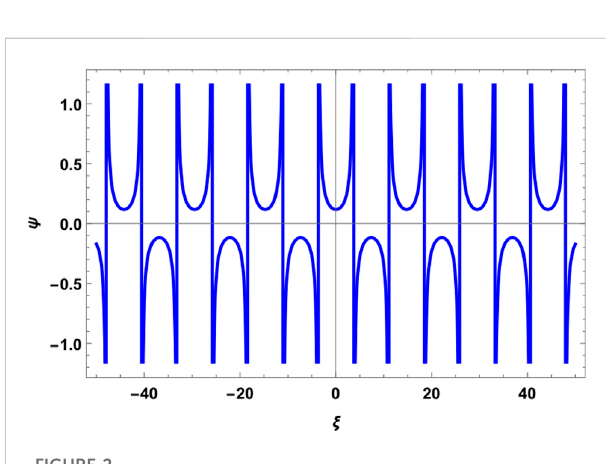
FIGURE 2 Periodic solution Cn for plasma parameters α =0.1, β =0.026,